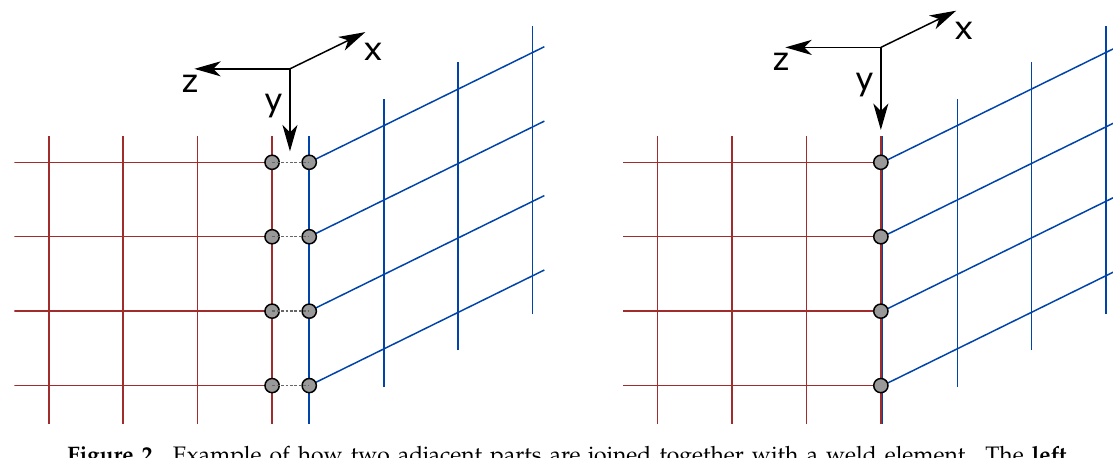
Figure 2. Example of how two adjacent parts are joined together with a weld element. The left panel shows the correspondence of nodes between both parts, however, the gap that appears is only introduced for the sake of clarity. On the right the actual position of both parts is shown, where corresponding nodes of each part are located exactly in the same place. The local reference system is also